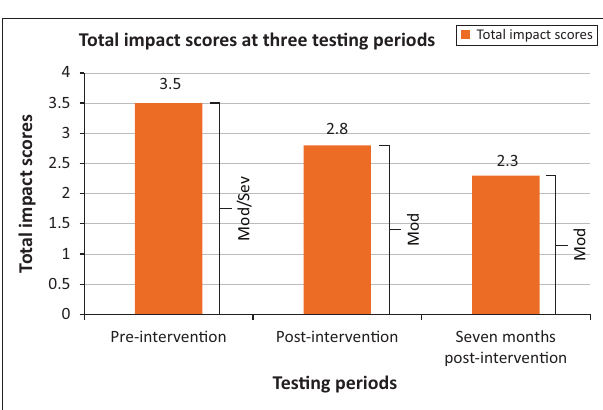
FIGURE 3: Participant’s Overall Assessment of the Speaker’s Experience of Stuttering results (total impact scores and severity ratings) at three testing